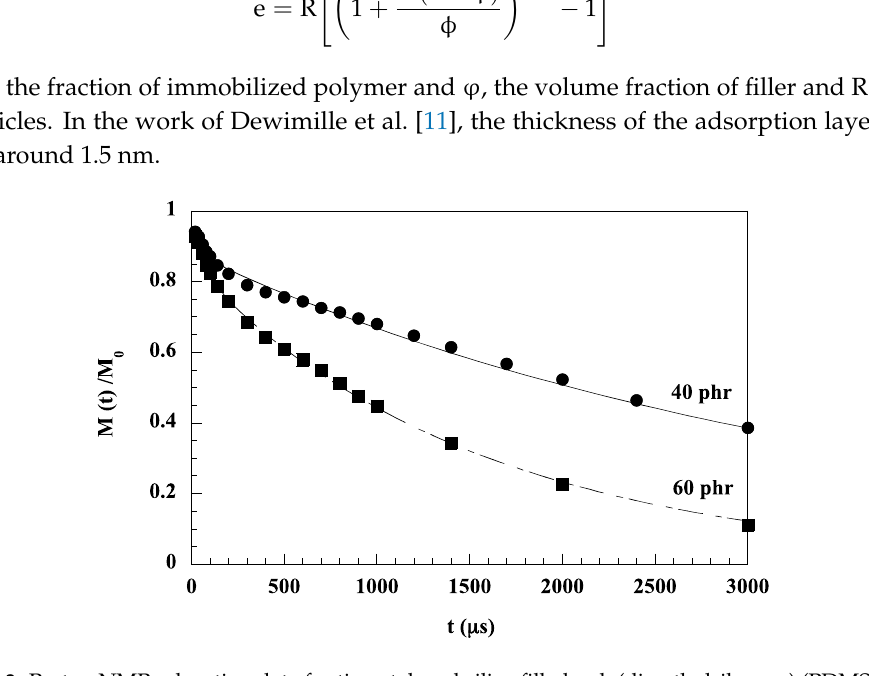
Figure 3. Proton NMR relaxation data for tin-catalyzed silica-filled poly(dimethylsiloxane) (PDMS/SiO 2 ) composites. Reprinted from reference [11] with permission from Elsevier.